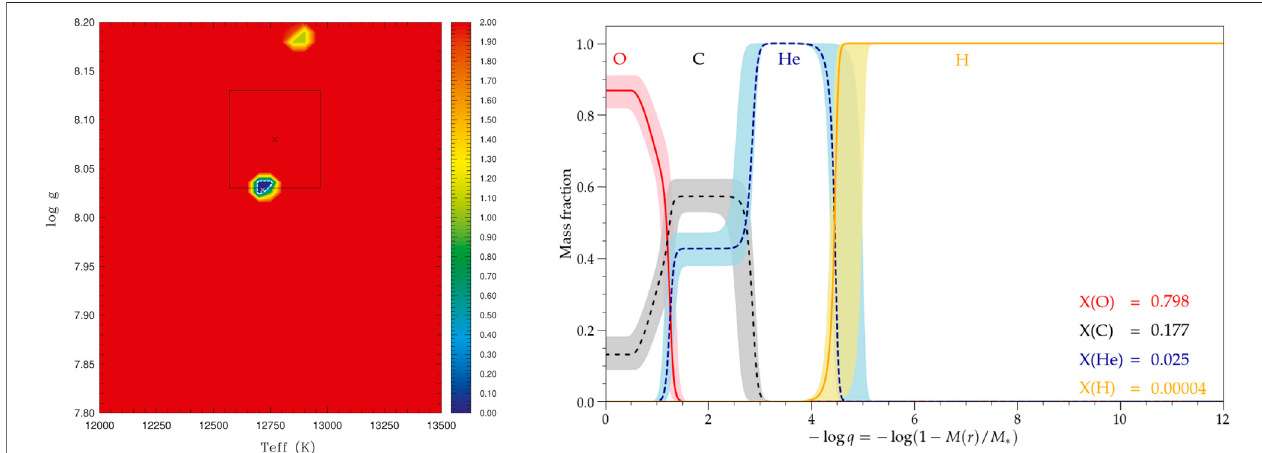
FIGURE 7 | Same as Figure 5 , but for the star EPIC 220347759.